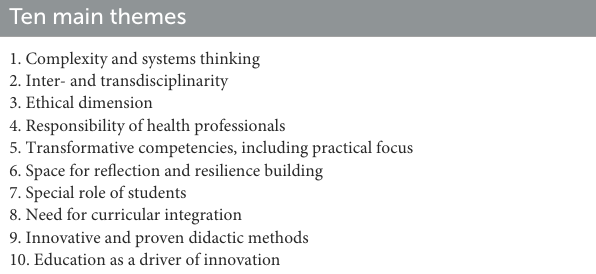
Table 3. The complete coding framework can be found at Supplementary material S4, verbatim supplement (VS) VS1-142 in Supplementary material S5,